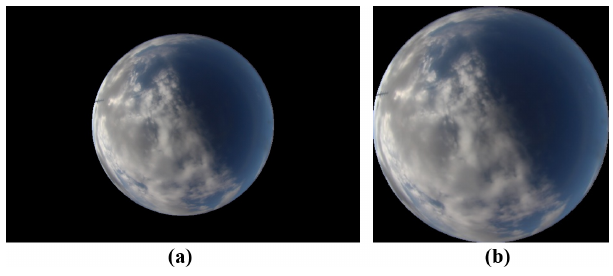
Figure 1. Example of ASC image. (a) Original RGB color ASC image. (b) Resized RGB color ASC image of (a)